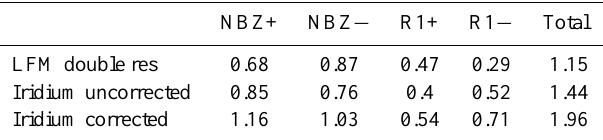
Table 1. Comparison of the integrated field aligned current (in MA) averaged from 16:00 UT to 19:00 UT on 16 July 2000 between Iridium and the double resolution LFM a